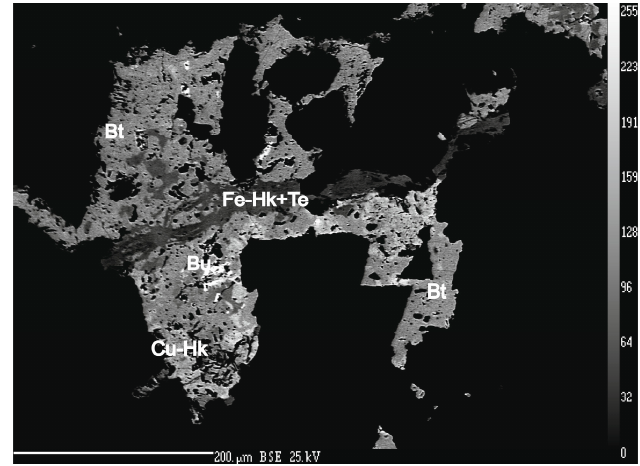
Figure 57. The complicated aggregate of dark grey Fe-hakite (Fe-Hk), Cu-hakite (Cu-Hk) and Fe-tetrahedrite (Te), bytízite (Bt), and bukovite (Bu). BSE photo. P ř íbram, a dump of shaft 16. Photo by J. Sejkora and P. Škácha.